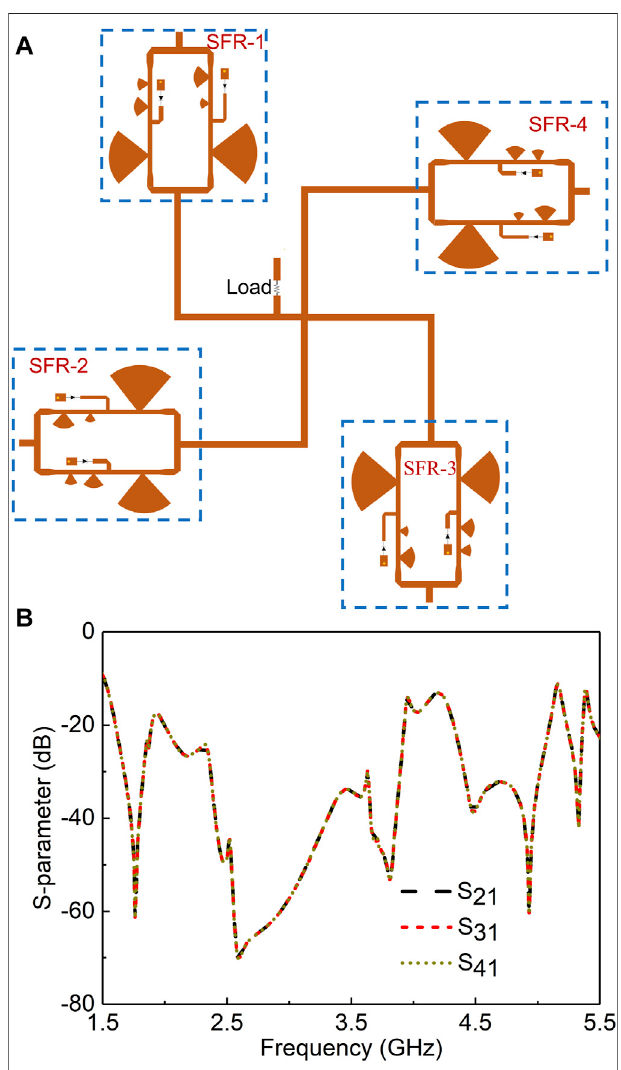
FIGURE 2 | (A) The topology of the proposed recti fi er array. (B) The simulated S 21 , S 31 , S 41 of the recti fi er array at an input power of − 10